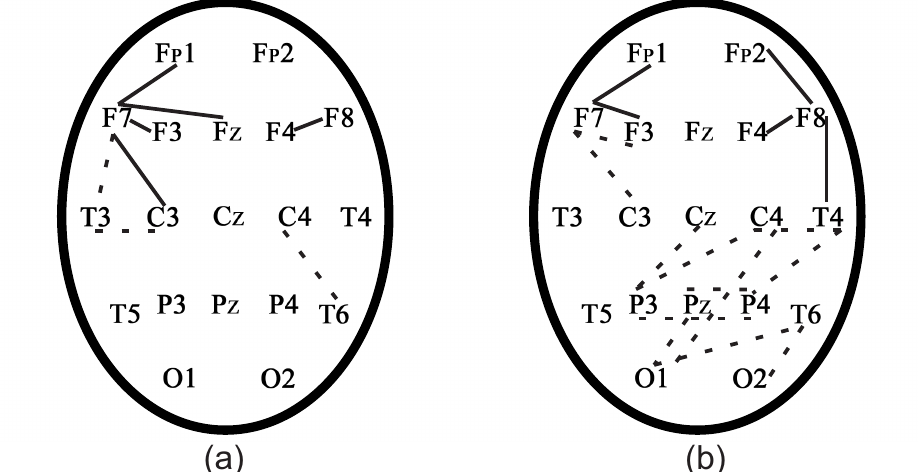
Figure 18. Phase-connected pairs of EEG channels of patients with TBI before (dotted lines) and after the rehabilitation (solid lines) in the CT1 test. ( a ) Patient 1. ( b ) Patient